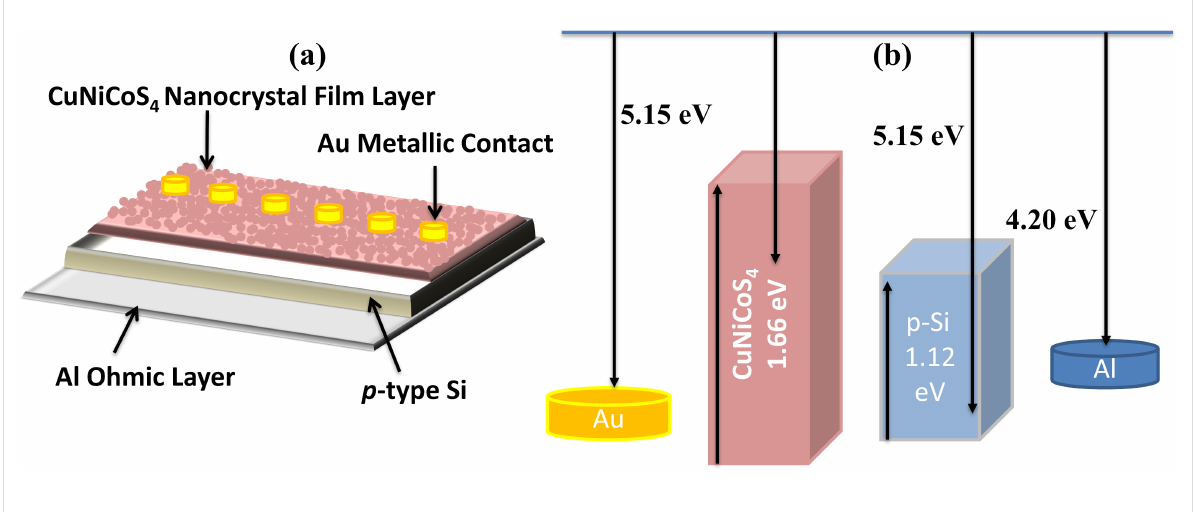
Figure 1: (a) Schematic illustration and (b) band diagram of the fabricated Au/CuNiCoS 4 /p-Si photodiode.